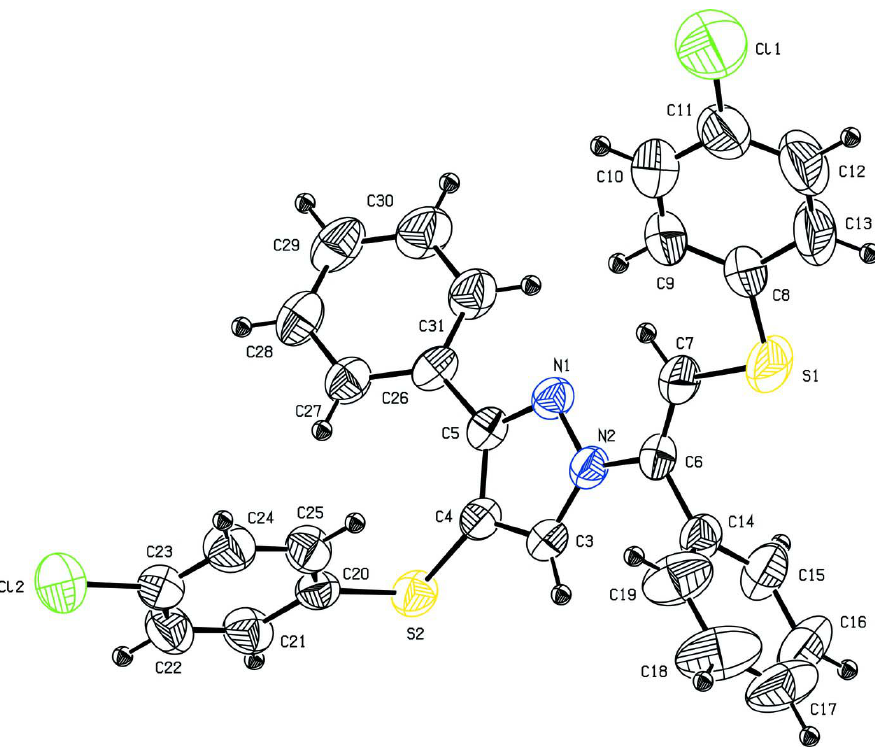
Figure 1 Molecular structure of the title compound, showing the atomic numbering and 50% probability displacement ellipsoids. 4-(4-Chlorophenylsulfanyl)-1-[( E )-2-(4-chlorophenylsulfanyl)-1- phenylethenyl]-3-phenyl-1 H